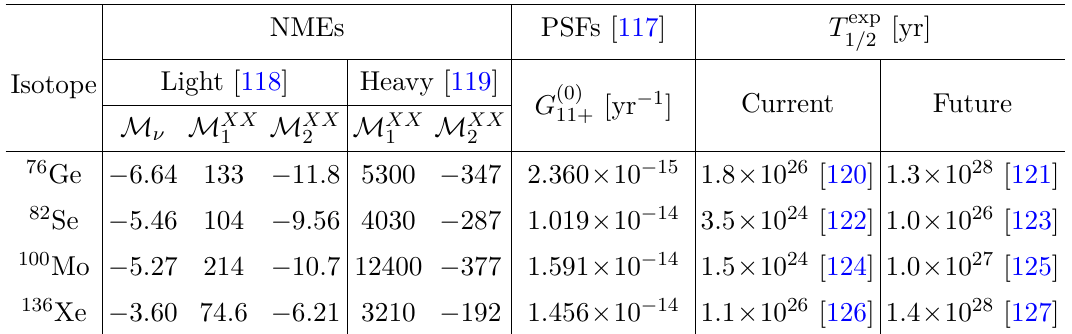
Table 2 . Values of the light and heavy NMEs calculated in the IBM-2 model for four different 0 νββ decay isotopes. For neutralino exchange we require light and heavy scalar and tensor NMEs M XX and M XX